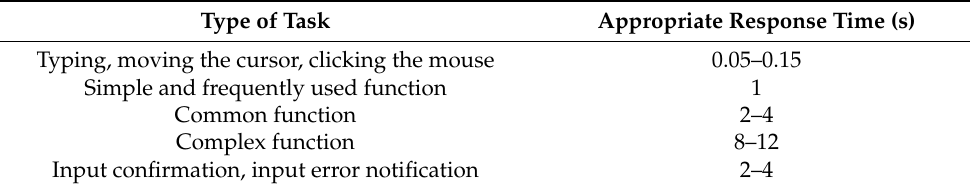
Table 5. User Preferred System Response Times.